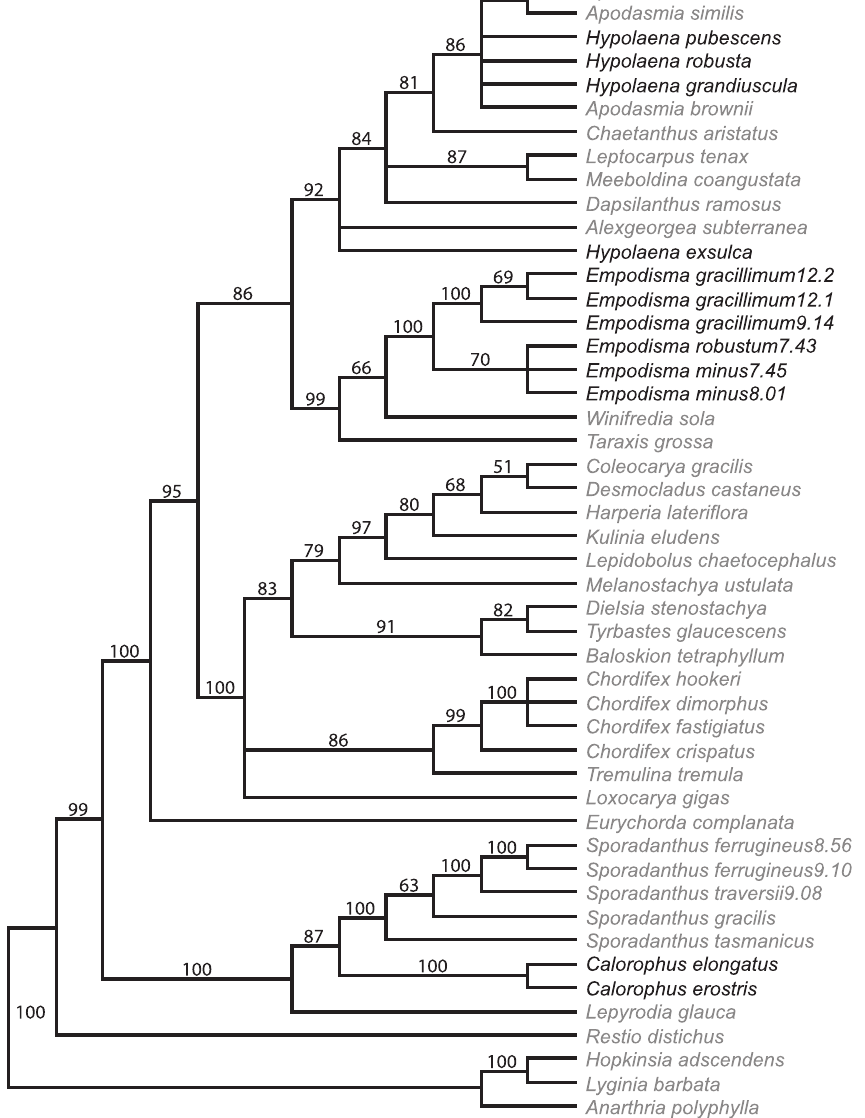
Figure 2. Strict consensus tree. The three species of Empodisma (highlighted in bold) emerge as a well- supported clade distinct from Calorophus and Hypolaena . They were placed in these latter two genera by Moore and Edgar (1970) and Cheeseman (1906). Bootstrap values are provided above the branches gene regions differed in length, the number of variable characters, and the degree to which they resolved and supported phylogenetic